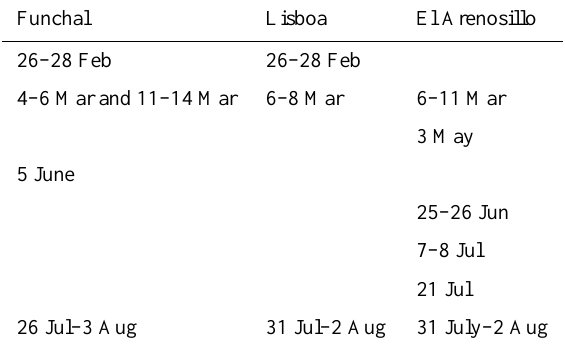
Table 2. Detected desert dust outbreaks at Funchal, Lisboa and El Arenosillo during year 2000 according AI values threshold. Funchal